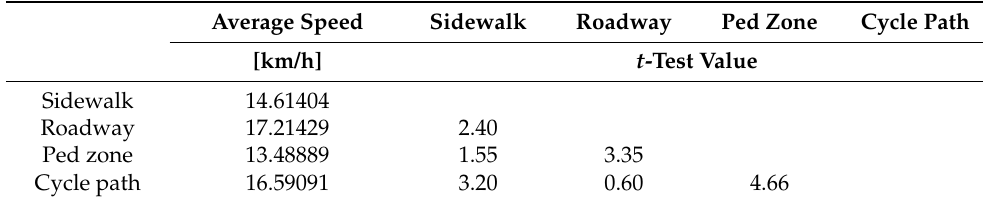
Table 8. t -test for the variable